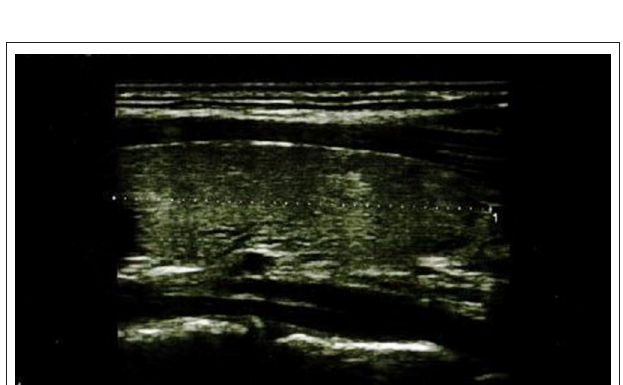
FIGURE 1 | Longitudinal image of thyroid gland with heterogeneous parenchymal echo pattern.